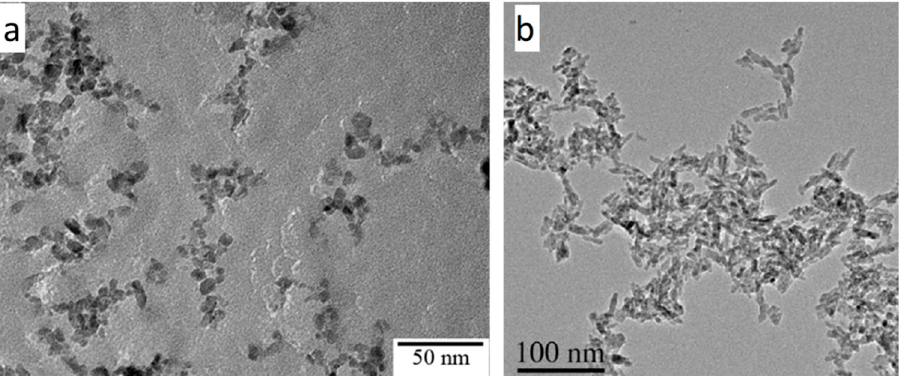
Figure 11. TEM micrographs of ( a ) TiO 2 anatase/brookite spherical nanoparticles, from [61] (reproduced with permission from J. G. Mahy et al., Journal of Photochemistry and Photobiology A: Chemistry; published by Elsevier, 2016) and ( b ) TiO 2 rutile nanorods, from [104] (reproduced with permission from S. Cassaignon et al., Journal of Physics and Chemistry of Solids; published by Elsevier, 2007).